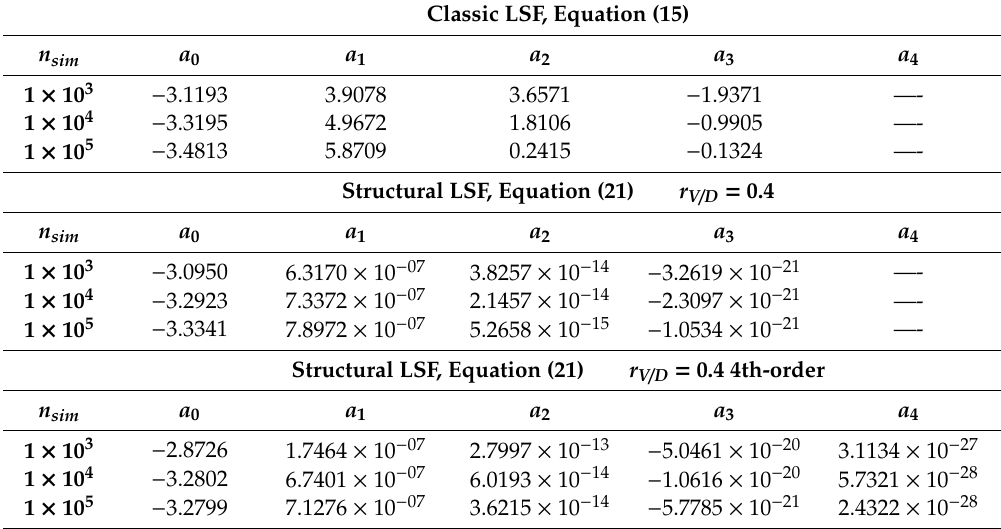
Table 1. Coe ffi cients of the fitted normality polynomials. Classic LSF, Equation (15)